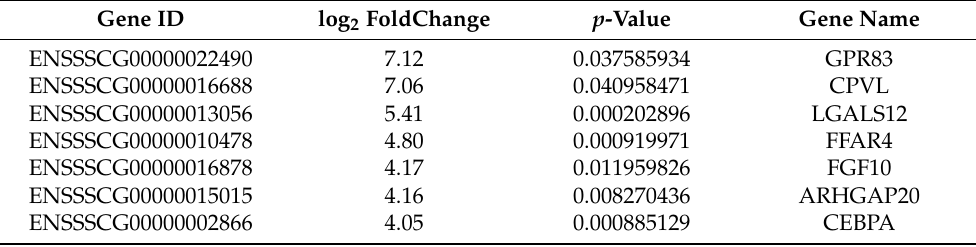
Table 3. Differentially expressed genes (DEGs) while comparing contralateral FA with LR-12 + TAK-242 treated AVF FA (+value = higher expression in AVF FA; − value = higher expression in contralateral